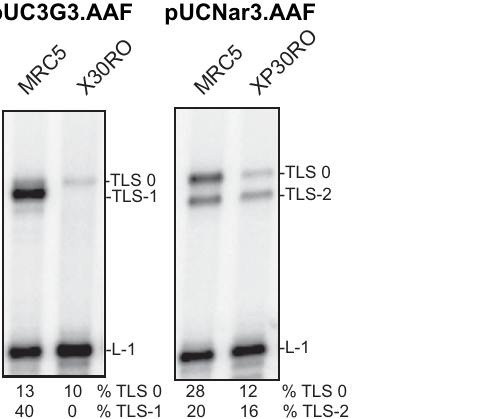
Figure 2. TLS through the G-AAF adduct in MRC5 and XP30RO cell-free extracts. MRC5 (WT) and XP30RO (Pol eta deficient) cell-free extracts (20 mg) were incubated 30 min at 37 u C in the presence of 10 fmoles of AAF-modified substrates either at the 3G sequence or at the NarI site in a final volume of 6.25 ml, as indicated. The samples were analysed by electrophoresis through a 8% denaturing polyacrylamide gel. L-1 is a product generated if synthesis is blocked one nucleotide before the lesion. TLS0 and TLS-1 or –2 are products from TLS via non- slipped and slipped intermediates, respectively.